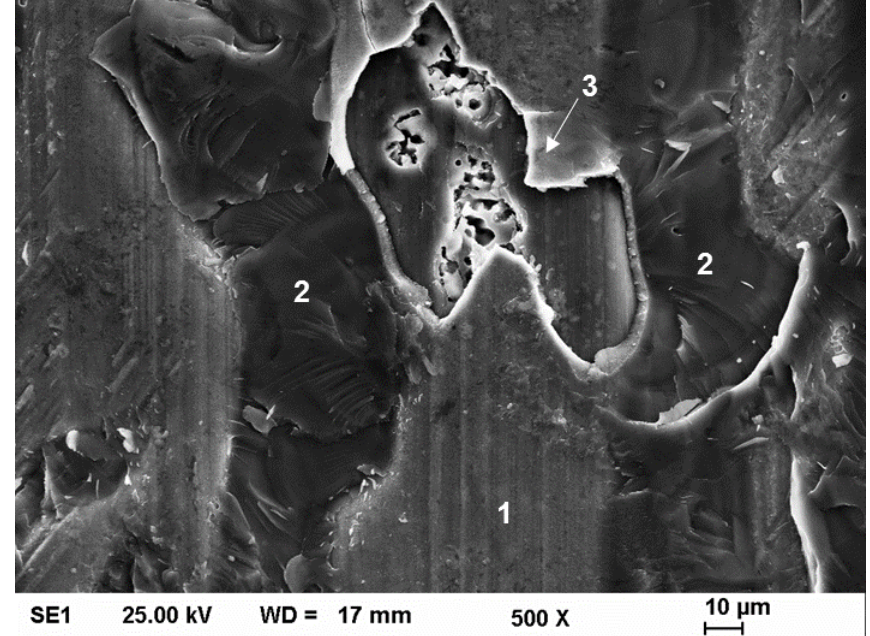
Figure 12. SEM image of a fracture surface of a AA 7020 and AZ 31B joint with titanium interlayer on the aluminium side and ( 1 ) the surface of the titanium coating, ( 2 ) intermetallic Al-Mg compounds and ( 3 ) a delamination of the coating from the aluminium surface.